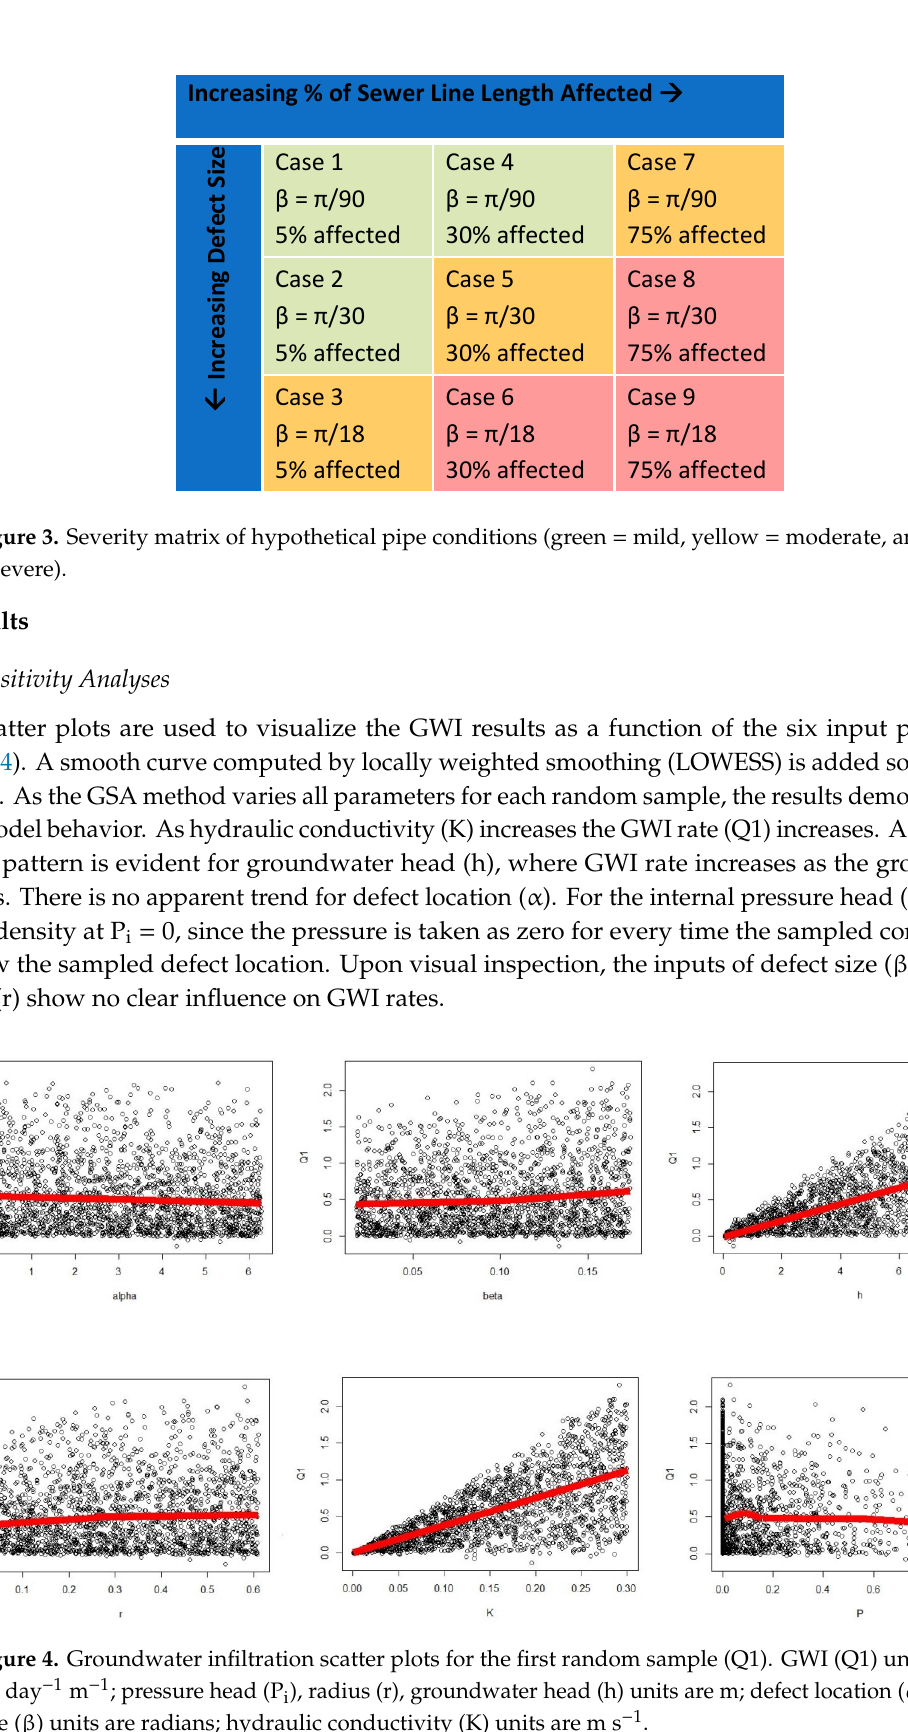
Figure 5. Main and total Sobol–Martinez sensitivity indices for the GWI model.